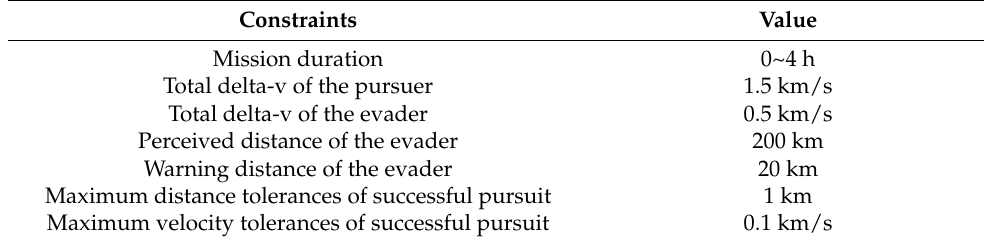
Table 1. The mission constraints of the sun-synchronous orbit PE game